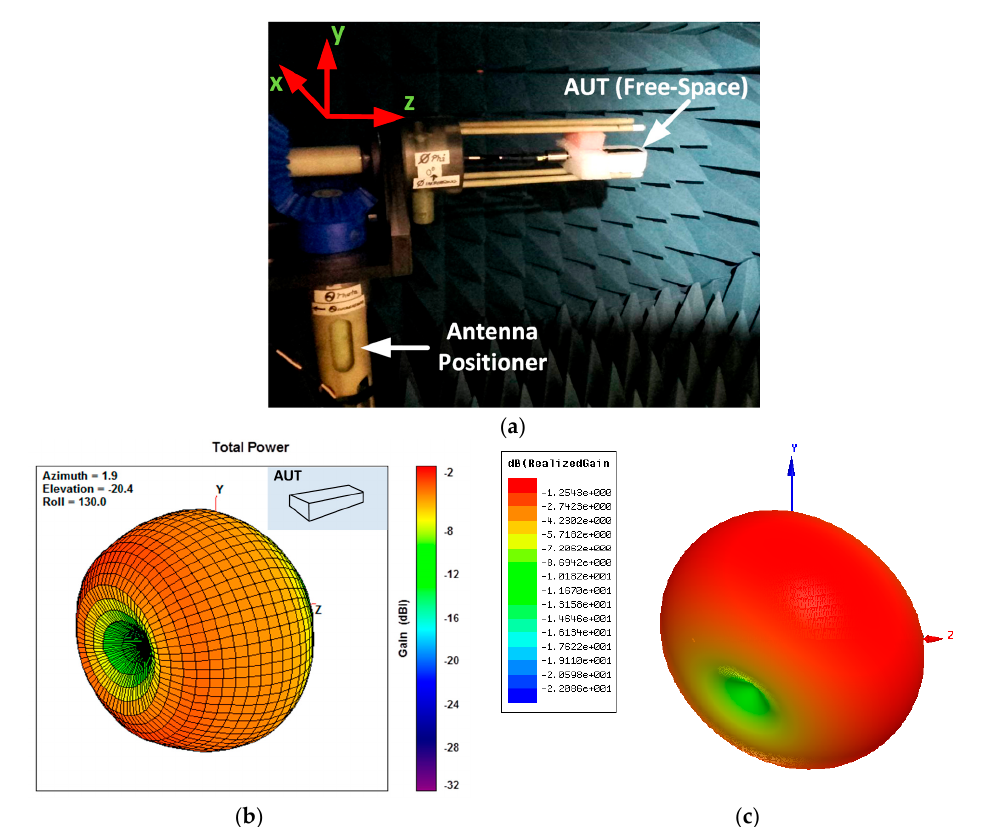
Figure 12. Radiation pattern measurements: ( a ) measurement setup in free-space scenario; ( b ) measured 3D radiation pattern of the antenna system in free-space; ( c ) simulated 3D radiation pattern of the antenna system in free-space.